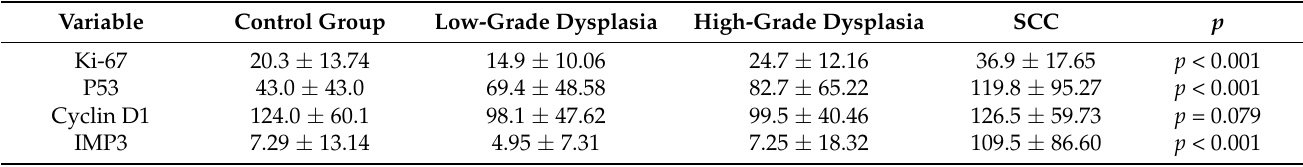
Table 2. Comparison of mean values of Ki-67, p53, cyclin D1, and IMP3 protein expression in laryngeal lesions.